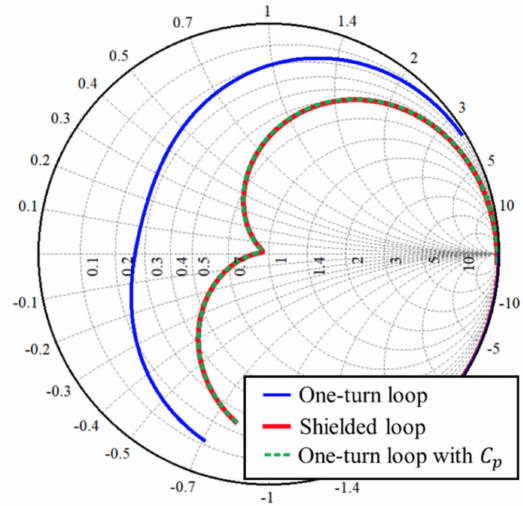
Figure 5. Smith chart of input impedance of loop coils.